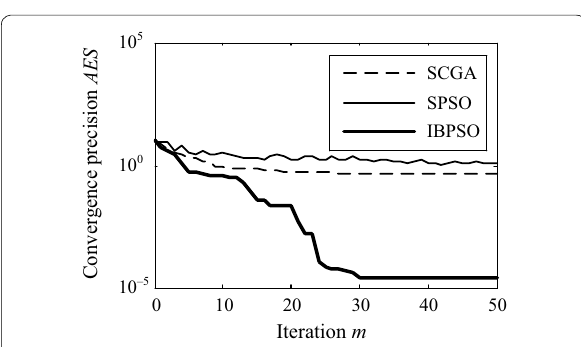
Figure 2 Convergence curves of three